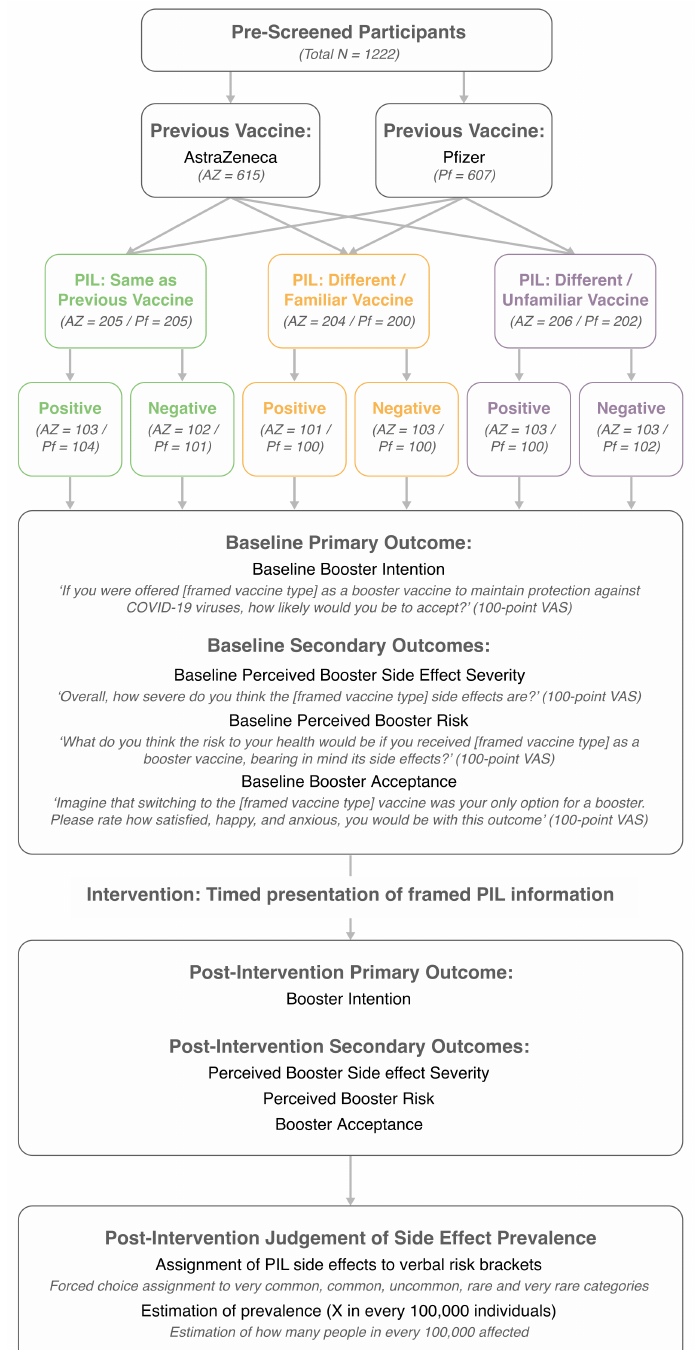
Figure 2. Overview of the design, including the item wording for primary and secondary outcomes. Nb. Satisfaction, happiness, and anxiety were rated separately as part of the booster acceptance measure. Primary and secondary outcomes employed a 100-point VAS with the following anchors: booster intention ( ‘definitely would not accept vaccine’ vs. ‘definitely would accept vaccine’) ; booster side effect severity ( ‘not at all severe’ vs. ‘extremely severe’ ); perceived booster risk ( ‘extremely low risk’ vs. ‘extremely high risk’ ); and booster acceptance ( ‘not at all’ vs. ‘extremely’